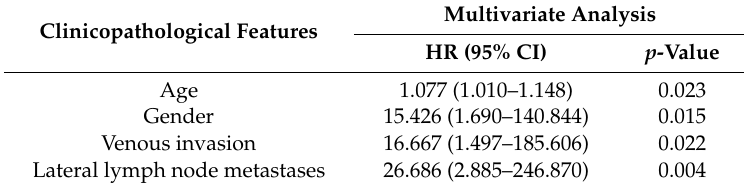
Table 6. Multivariate logistic regression analysis regarding PTC-specific